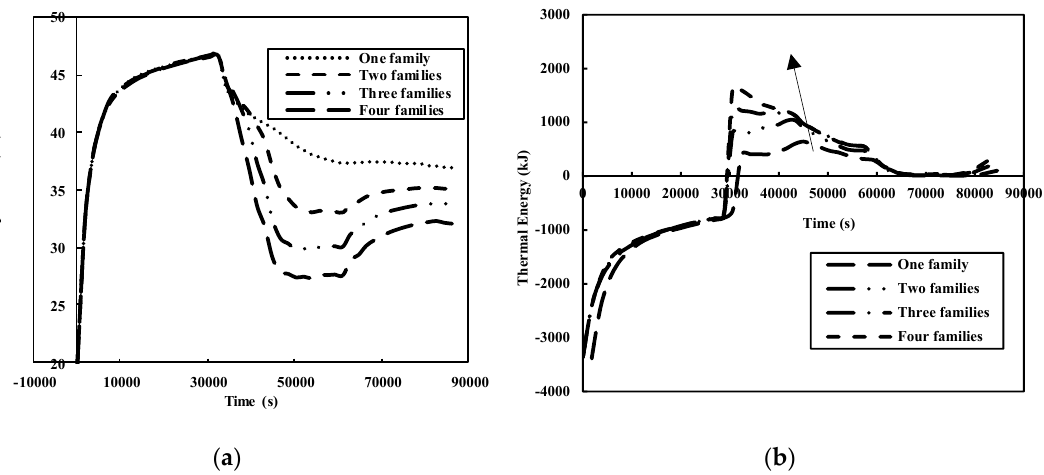
Figure 9. Outlet water temperatures and thermal energy over one day of operation. ( a ) Outlet temperature variation versus number of families; ( b ) Thermal energy stored and recovered during the day for the demands of one, two, three, and four families. Table 4. Thermal storage efficiencies for multiple families.